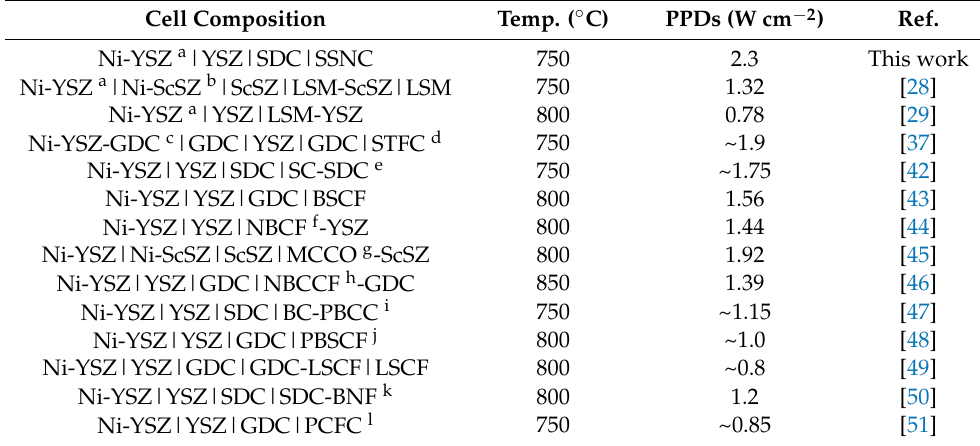
Table 2. Comparison of the electrochemical performance of various